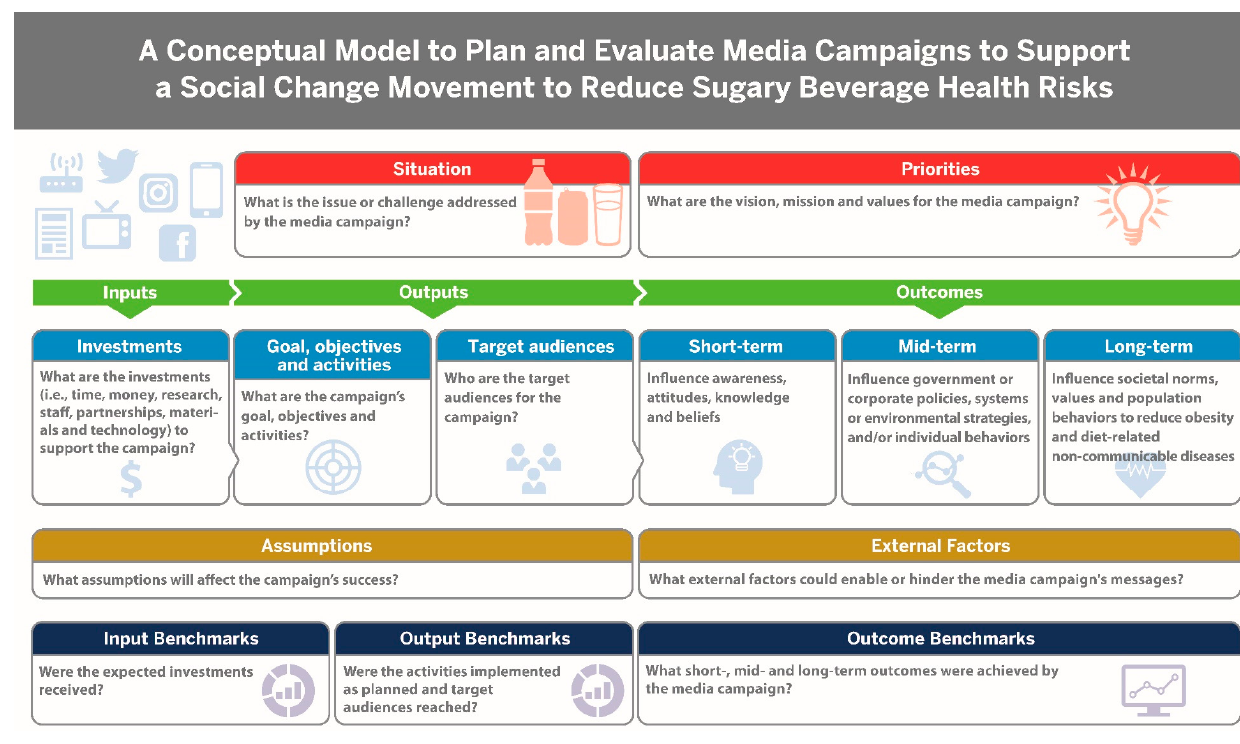
Figure 3. A c onceptual model to plan and evaluate media campaigns to support a social change movement to reduce sugary beverage health risks. Adapted from: Foster, B.; Horton, B.; DeFrancesco, L.; Wedeles, J. Evaluating Social Change. Washington, DC: Vanguard Communications Purple Paper; 2012 (reference [35]).